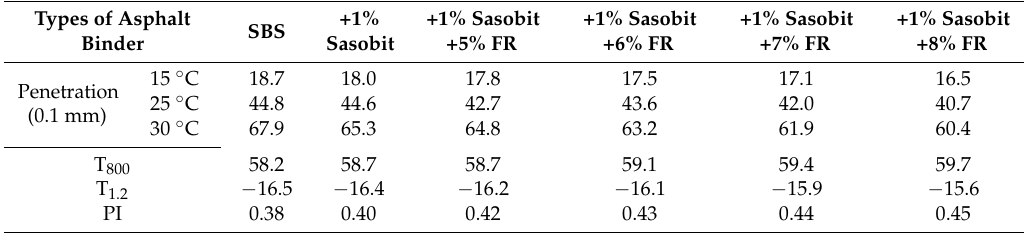
Table 4. Results of the penetration